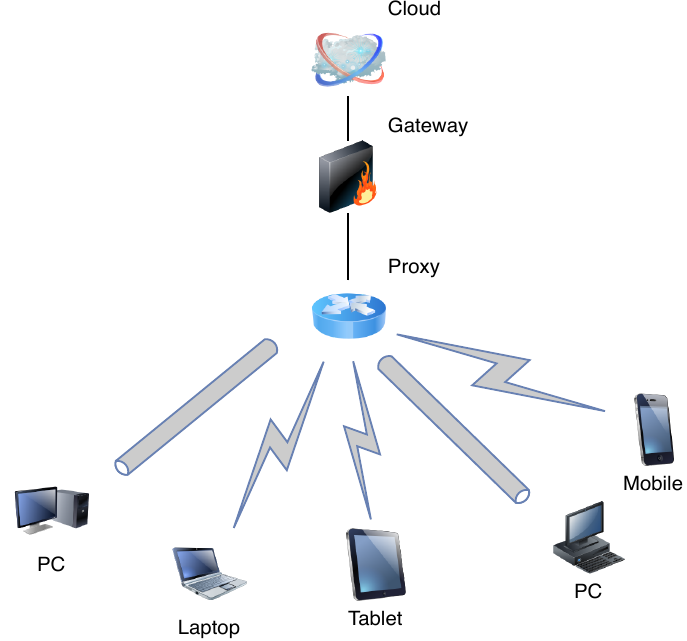
Figure 1. Edge computing network composition